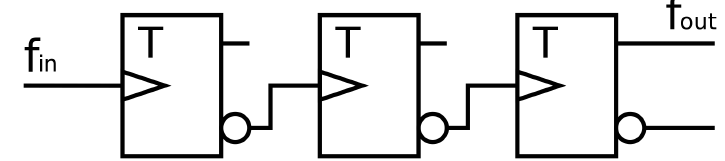
Figure 4. Frequency divider with three flip-flops.